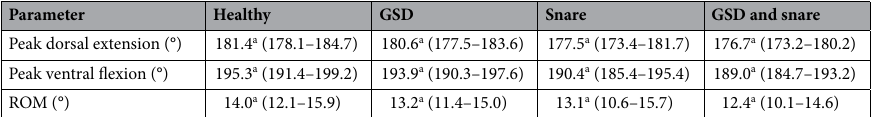
Table 7. Pairwise comparisons of estimated marginal means for neck angle kinematics among different giraffe conditions in free-ranging Nubian giraffe ( Giraffa camelopardalis camelopardalis ). Parentheses contain 95% confidence intervals. Shared superscripts within a row indicate that estimated marginal means were not significantly different.